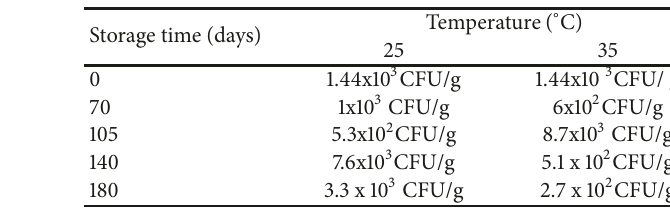
Table 3: Mold and yeast count in the dietetic functional mixed cerrado fruit jam during